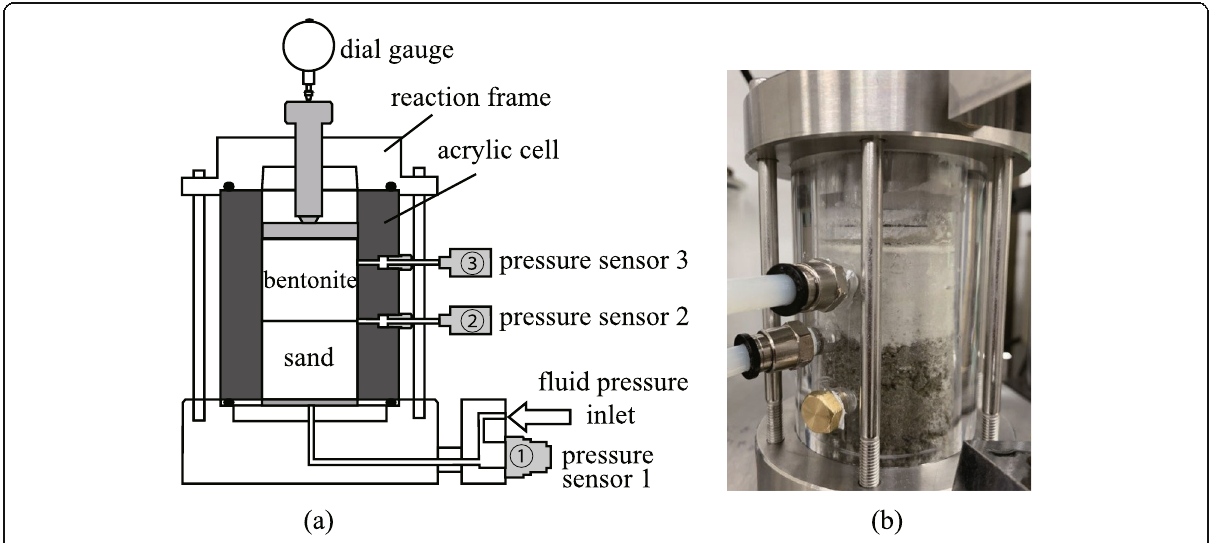
Fig. 6 Experimental configuration: a Schematic representation of the tensile test for the two-layer specimen. Fluid pressures were measured by pressure sensors installed at the fluid pressure inlet (bottom), layer interface, and upper layer; and b photograph of a specimen showing flow lines to the pressure sensors, a specimen-filled acrylic cell, and reaction frame